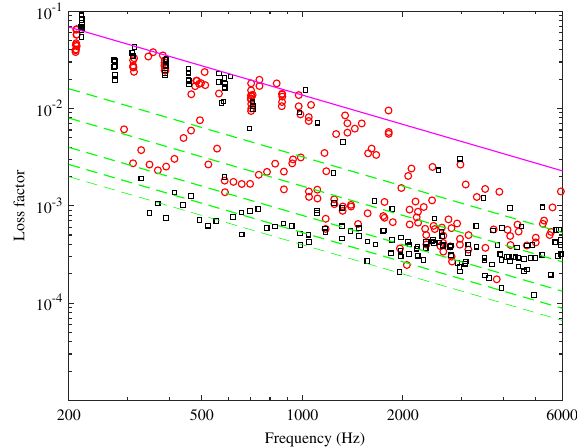
Figure 4. Loss factor versus frequency for modes excited by plucking the top string of the guitar (black squares) and the banjo (red circles). The analysis method cannot detect modes signi fi cantly above the magenta line. Green dashed lines indicate decay time constants ( xg ) (cid:1) 1 = 50 ms (top line), 100 ms, 200 ms, 300 ms and 400 ms (lowest